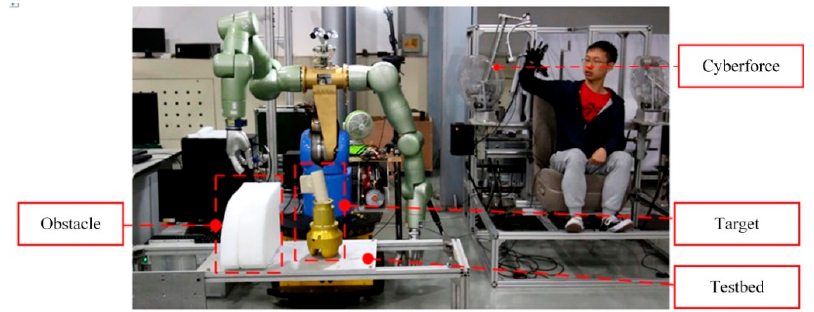
Figure 13. Experiment setup for fine space.